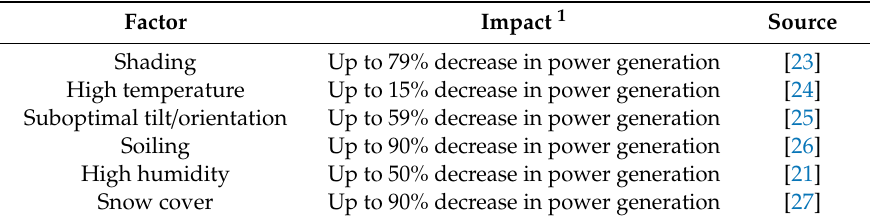
Table 2. External factors impairing electricity